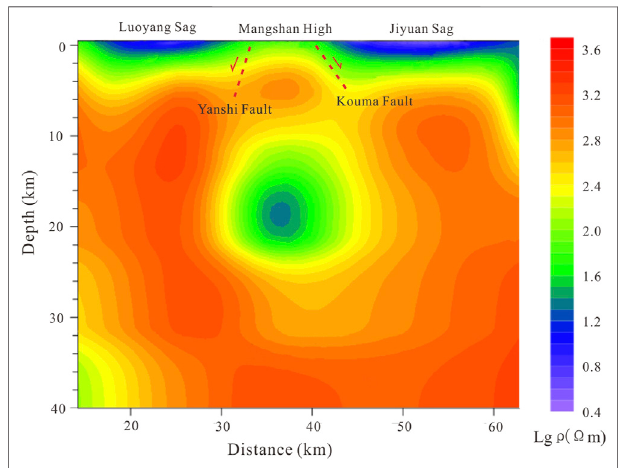
FIGURE 5 | The magnetotelluric two-dimensional electrical interpretation